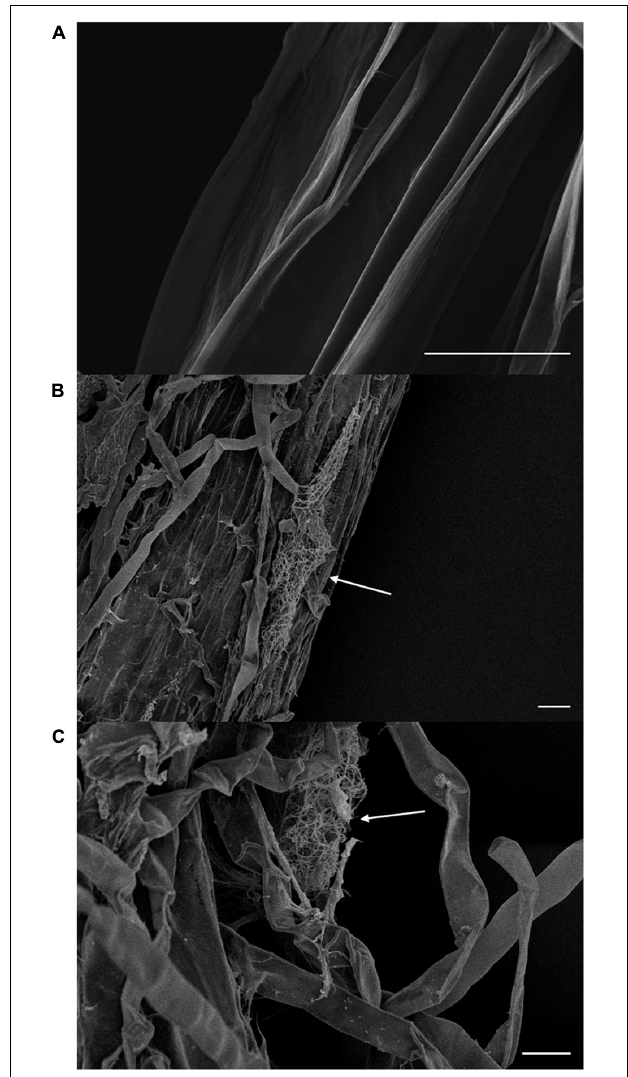
FIGURE 3 | Streptomyces griseorubiginosus BTU6 colonizes the root surface (B) and hair area (C) of sugarcane and forms a mycelial cluster. (A) Represents a control sugarcane plant without BTU6 inoculation. Scale bar = 20 µ